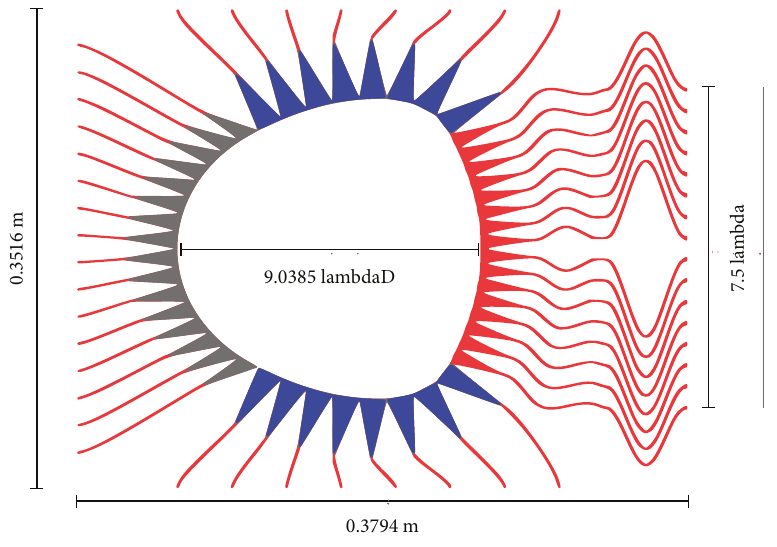
Figure 2: Lens obtained through RLD. Table 1: Parameters for the Rotman